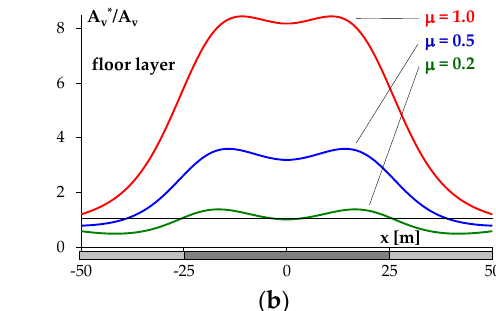
Figure 9. Distribution of the energy concentration coefficient of shear strain for different strain prop-